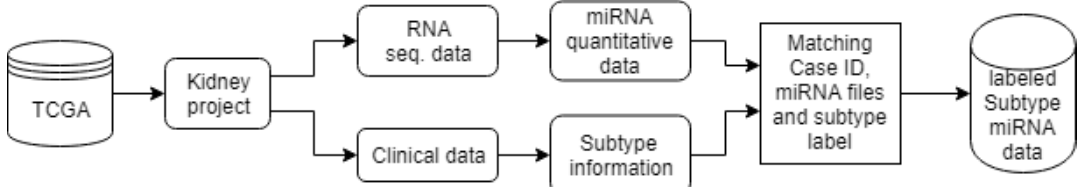
Figure 3. Data preparation for kidney cancer subtype